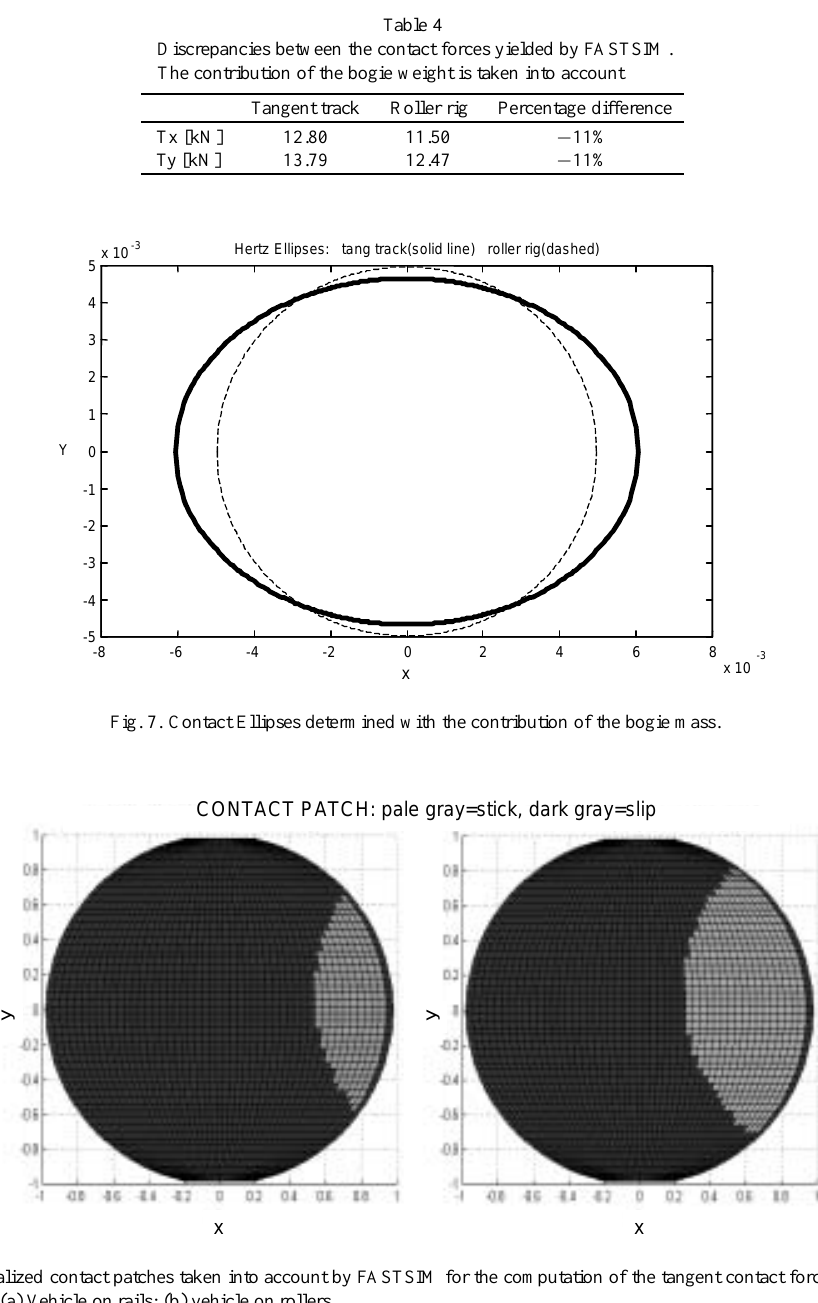
accordance with the general results of [14], is located at the leading edge side. Unlike the linear model, the bogie weight increases the difference between the wheel-rail and the wheel-roller contact forces. However, computing the non-linear contact forces with Kalker’s FASTSIM [17], the percentage differences between the forces yielded by the two kinds of contact is less evident than in the linear theory. This is due to the fact that, in the simplified theory, the adhesion area in the roller rig contact patch increases as the Figs 8 and 9 show. This effect partially compensates the negative effects due to a less extended contact patch and to a smaller ratio a/b